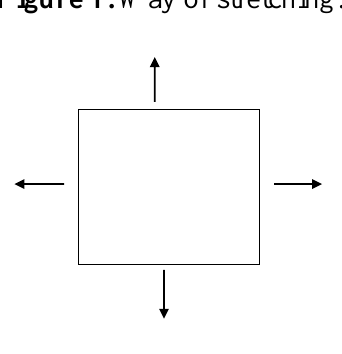
Figure 1. Way of stretching.